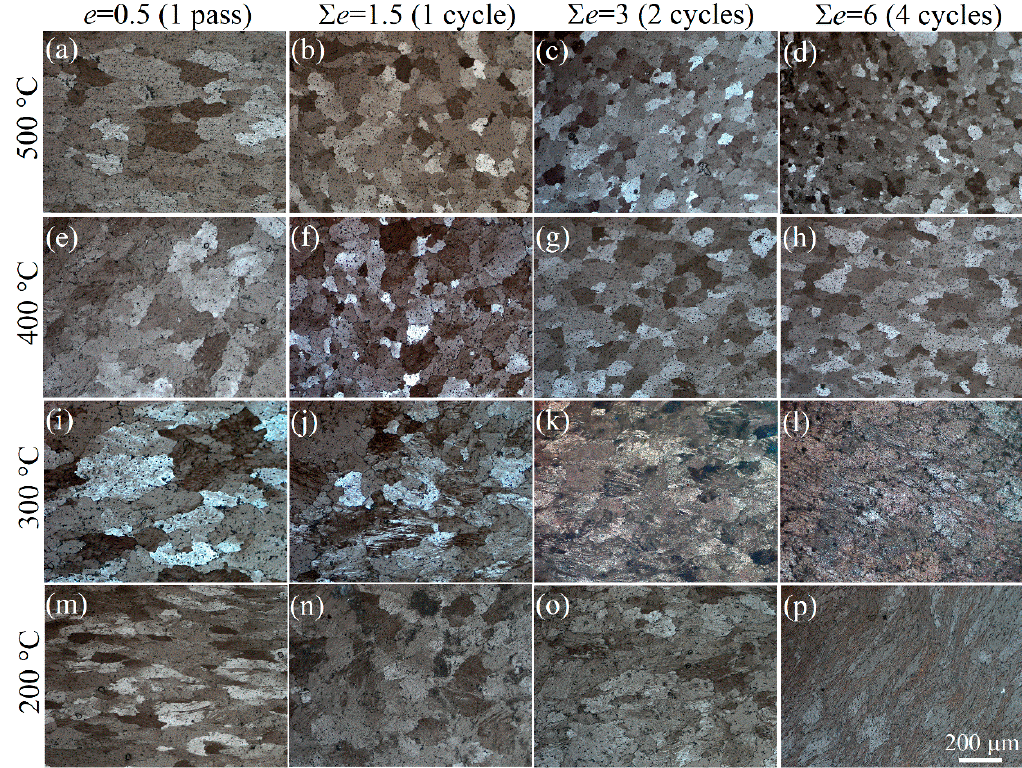
Figure 4. Microstructure of the samples in the near-surface layer after IMF for different strains (0.5–6.0) and temperatures (500–200 °C); detailed descriptions of temperatures and strains are provided in the figure.